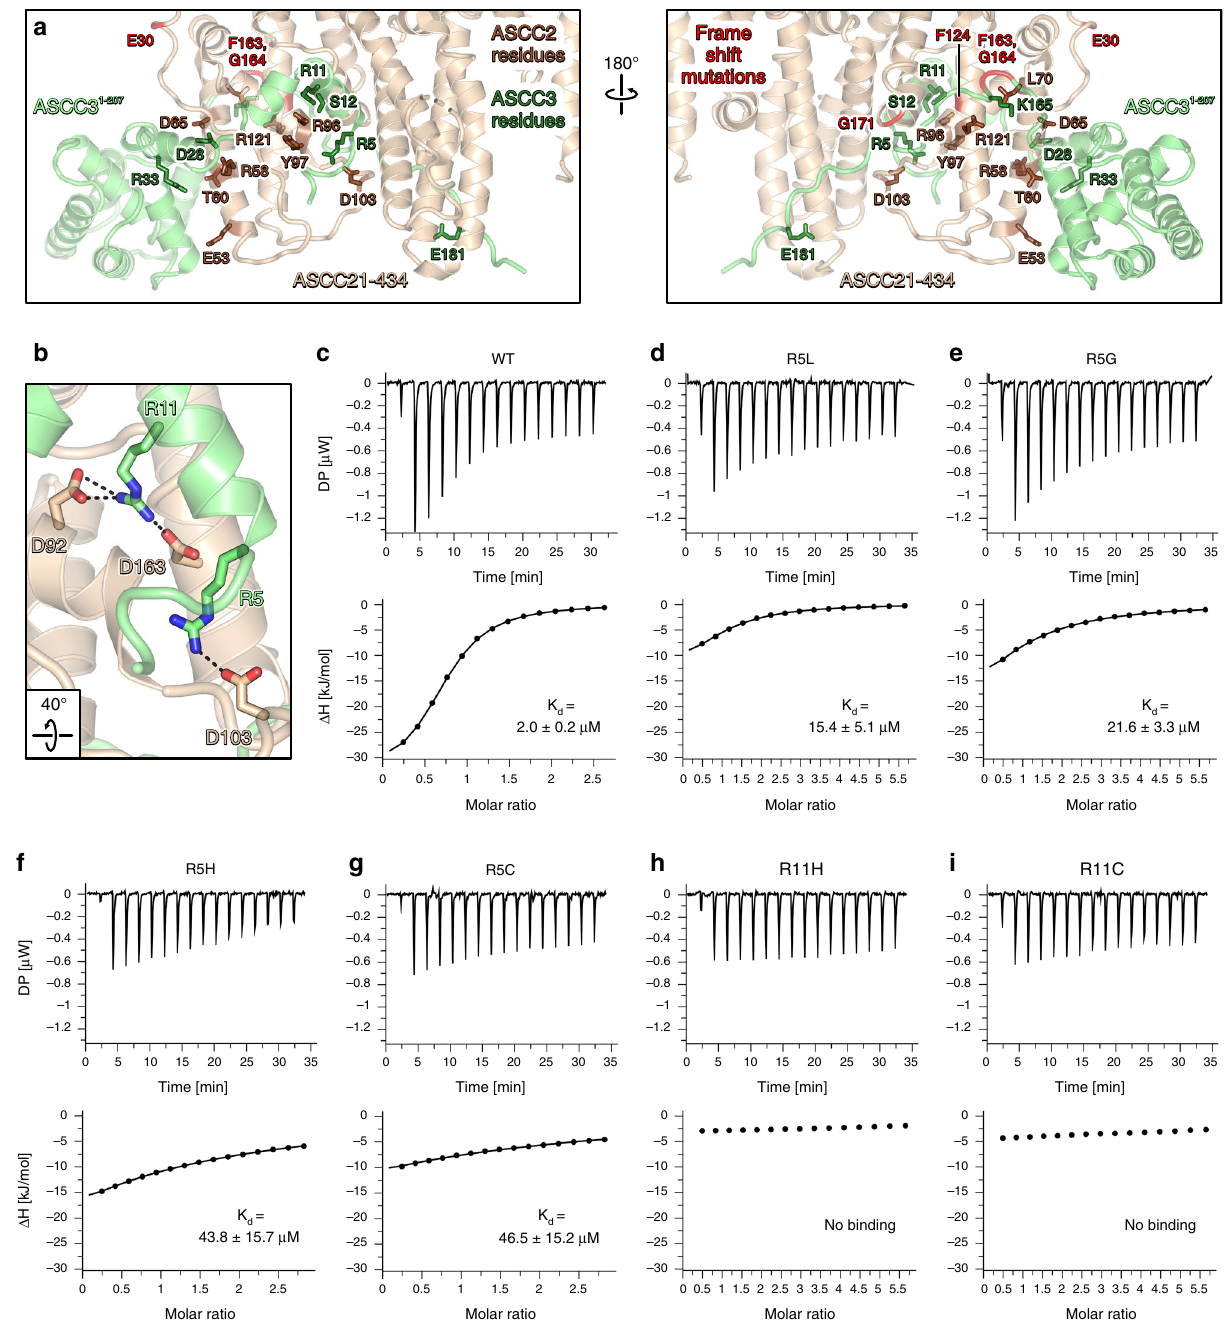
Fig. 4 Interface residues in ASCC2 and ASCC3 affected by somatic cancer mutations. a Orthogonal views on the ASCC2 1 – 434 -ASCC3 1 – 207 structure, highlighting interface residues and frameshift positions affected by somatic cancer mutations. ASCC2 1 – 434 , beige; ASCC3 1 – 207 , lime green; ASCC2 residues, brown sticks; ASCC3 residues, dark green sticks; fi rst positions affected by frameshift mutations, red. Orientations of the panels as in Fig. 1d,f. b Details of the interaction networks involving cancer-related residues D103 of ASCC2, as well as R5 and R11 of ASCC3. Dashed lines, salt bridges. Rotation symbol, view relative to Fig. 1d,f, left. c – i ITC runs monitoring the interaction of ASCC2 1 – 434 with the indicated ASCC3 1 – 22 peptide variants. Deduced K d values are listed as means ± SD for runs for which af fi nities could be quanti fi